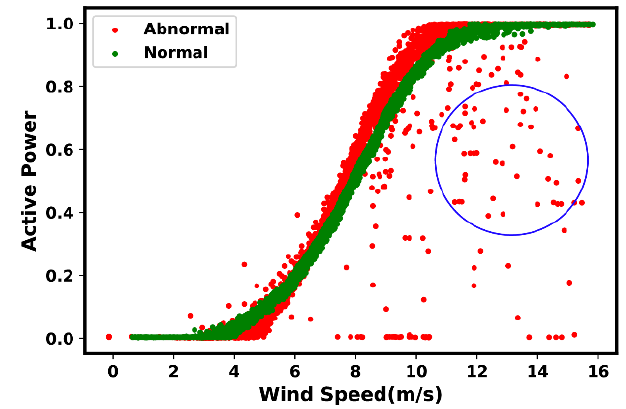
Figure 9. Type 4: Dispersive (Spread) Data.